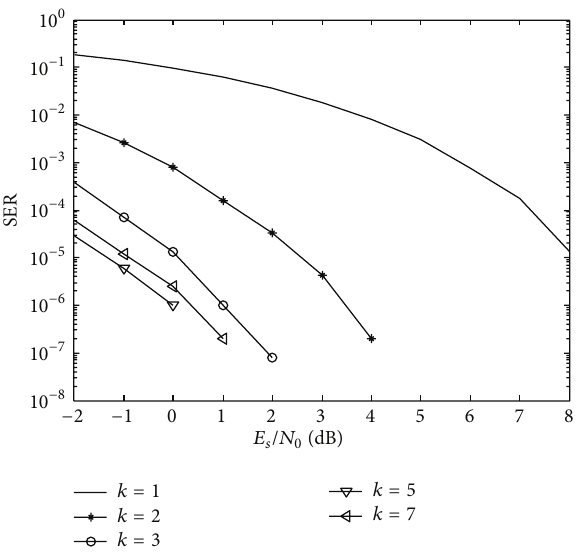
Figure 9: Comparative SER results of 𝐾 = 1,2, 3, 5,7